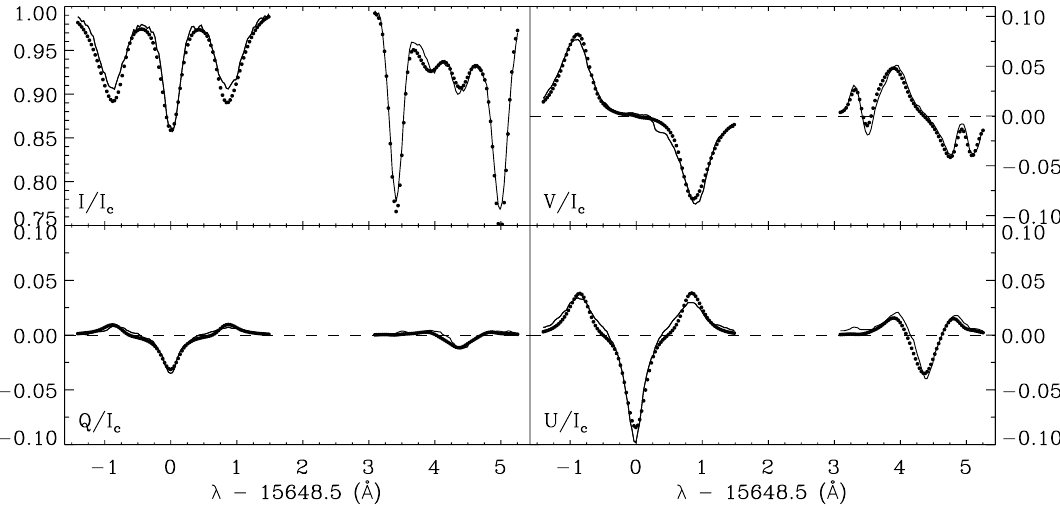
Figure 10: Fits to the Stokes spectra for the 1565 nm Fe line pair. Here the Fe and OH lines are both fit using response functions computed for each line. Image reproduced with permission from Mathew et al. (2003), copyright by